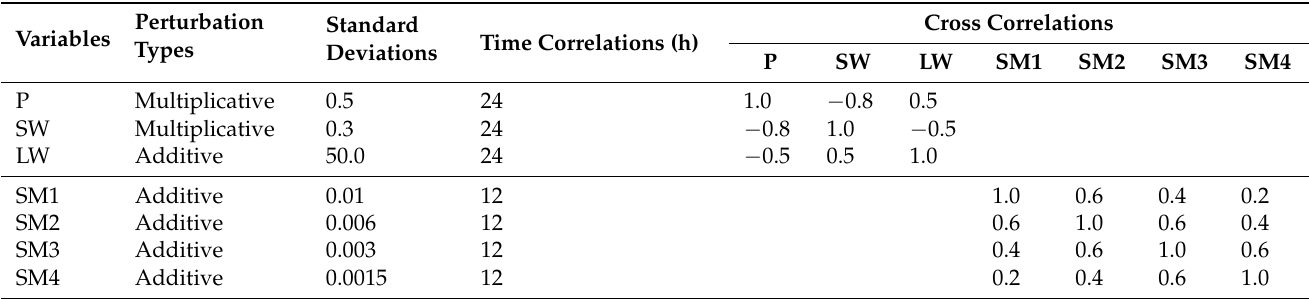
Table 1. Parameters for generating perturbations to the atmospheric forcing variables and soil moisture of LSM in EnKF. P is precipitation, SW is downward shortwave radiation, LW is downward longwave radiation, and SM1–SM4 are the LSM prognostic soil moisture at the first soil layer to the fourth soil